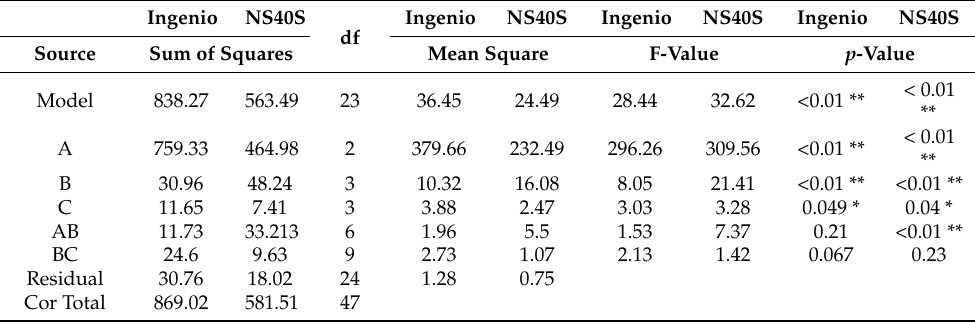
Table 12. ANOVA table for biomass for the three-year time range (2018–2020).